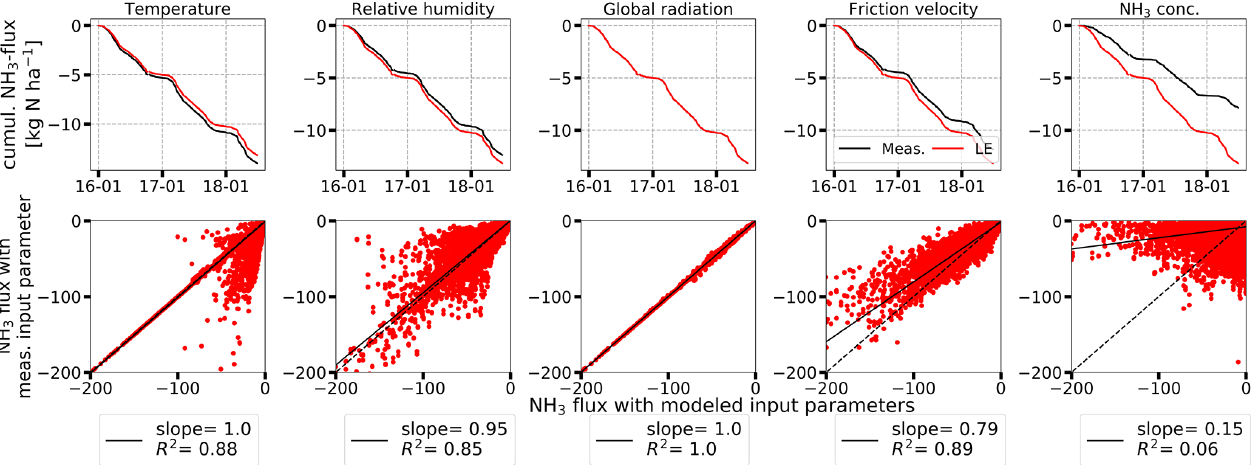
Figure 5. Comparison of NH 3 fluxes calculated with DEPAC-1D for the land-use class spruce forest based on measured (black) and modeled input data (red). The comparison was made for temperature, relative humidity, global radiation, friction velocity, and NH 3 concentrations. In the first row, NH 3 fluxes are shown as cumulative sums in kgNha − 1 . In the second row, scatter plots of NH 3 fluxes in ngNm − 2 s − 1 are given. Linear regressions are shown as black, solid lines; black, dashed lines represent 1 : 1